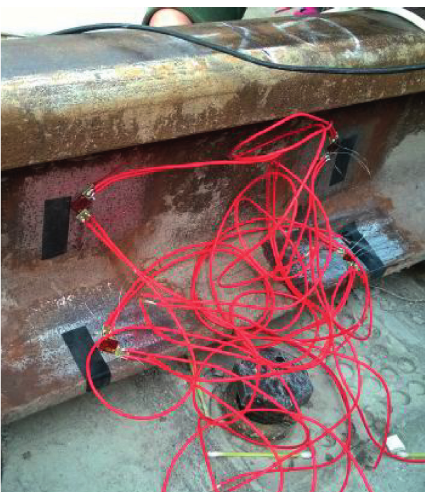
Figure 6: A scene from the field tests for the wheel-rail forces of a high-speed